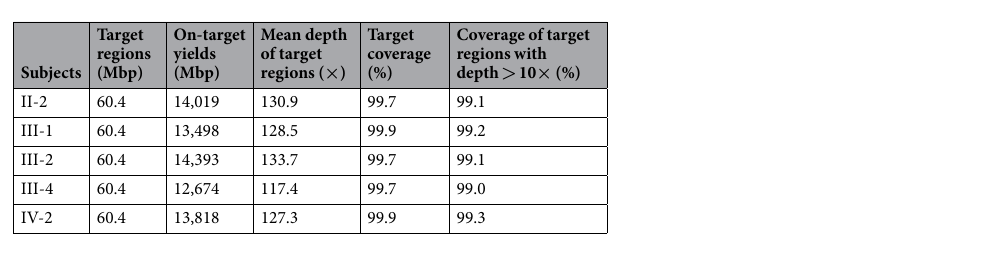
Table 2. Whole-exome sequencing statistics and